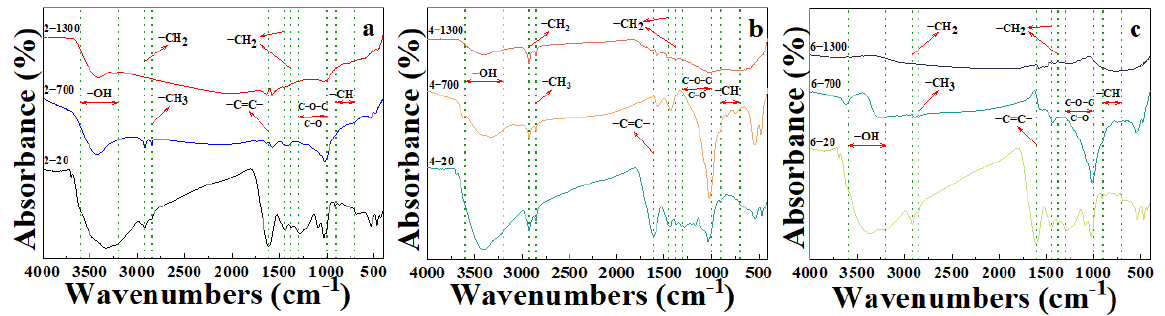
Figure 4. FTIR spectra of lignite samples prepared at high pressure of ( a ) 2 GPa, ( b ) 4 GPa, and ( c ) 6 GPa.